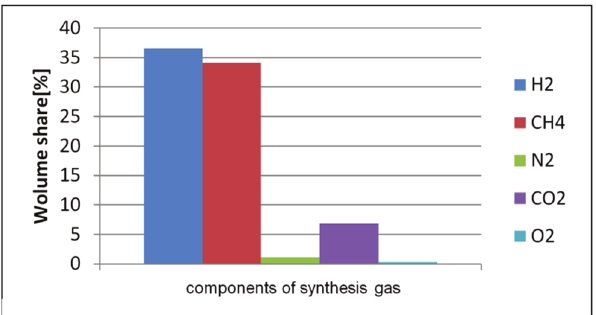
Fig. 8. Volume fraction of syngas components Each average of approximately 4.17 kWh of energy was used to process each 100 g glycerol. A total of 1 m 3 of syngas was produced for engine tests. About 2.5 kg of glycerine was used to produce this volume of synthesis gas. Comparison of the operation of the engine powered by LPG and synthesis gas shows the fundamental difference in fuel consumption. The consumption of synthesis gas is several times greater than the consumption of LPG. This is due to the significantly lower heating value of synthesis gas and the heating value of the syngas and air mixture. There is also a difference in the temperature of the exhaust gas.